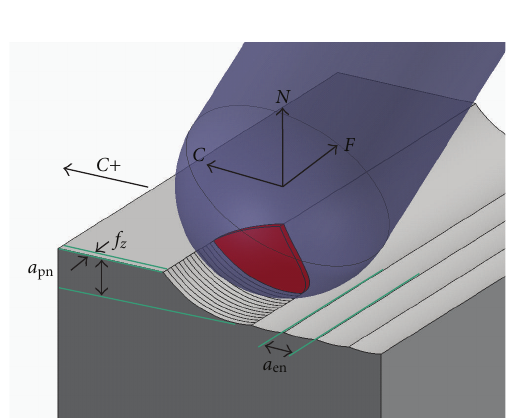
Figure 6: Contact conditions and reference system for ball-end milling.